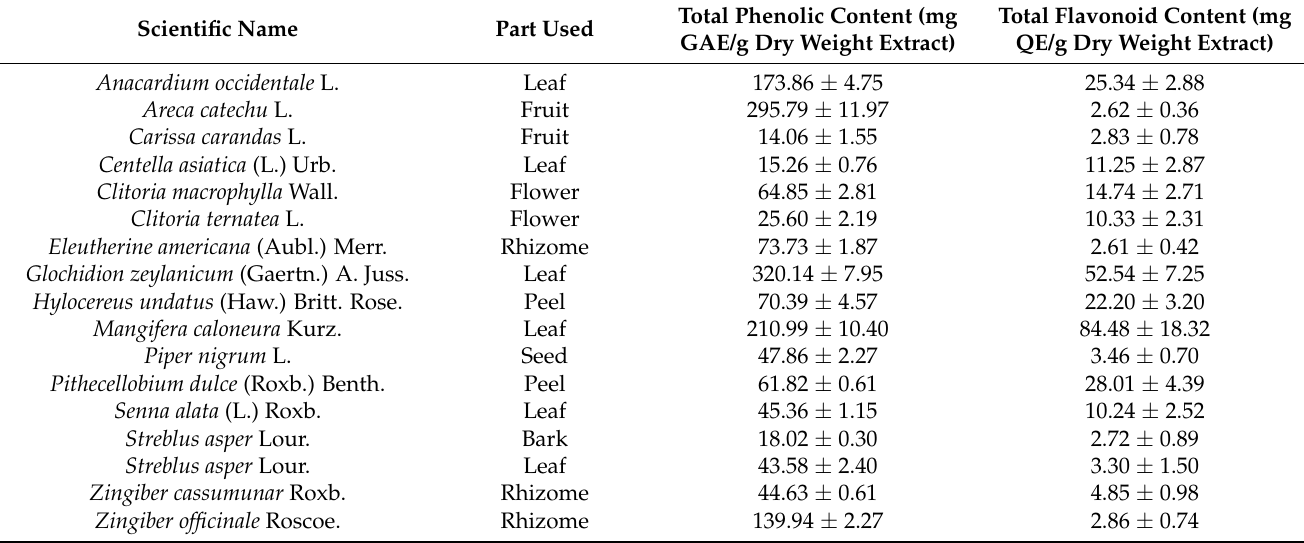
Table 2. Total phenolic and flavonoid contents of Thai